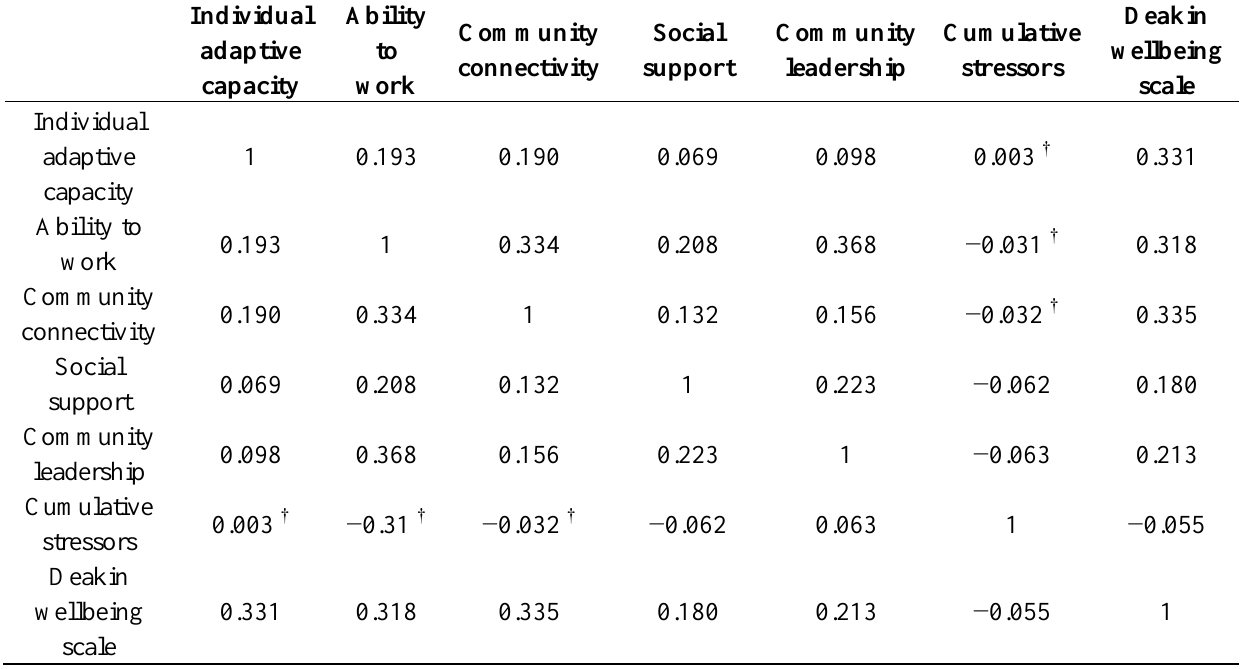
Table 5. Correlations between items measuring adaptive capacity and wellbeing.